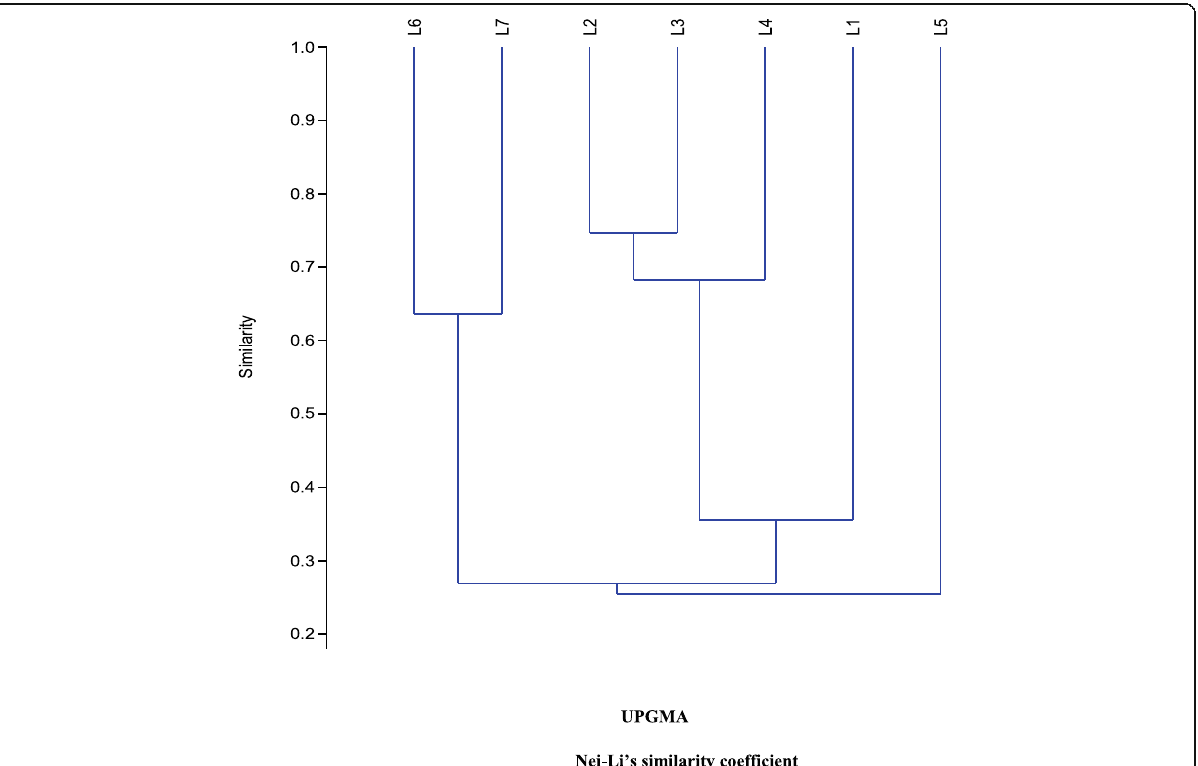
Fig. 3 Dendrogram representing the genetic relationship among the seven wheat genotypes using UPGMA cluster analysis of Nei-Li ’ s similarity coefficient generated from the six ISSR